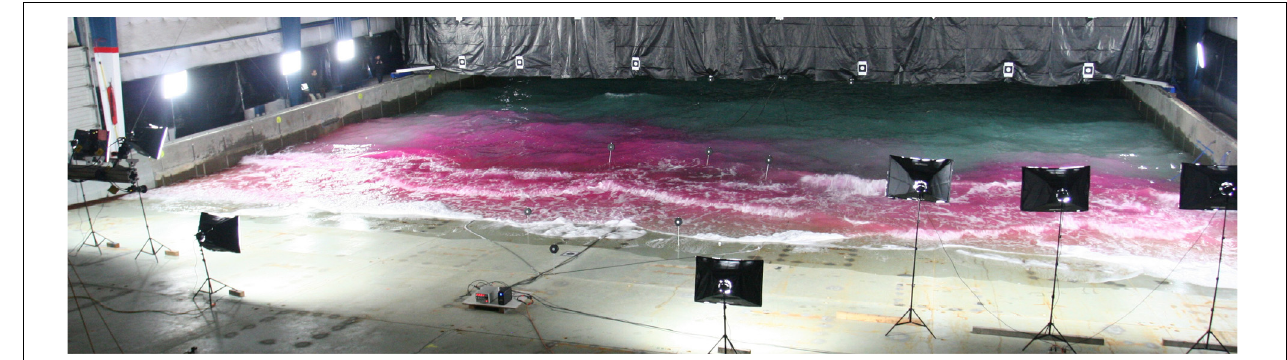
FIGURE 11 | Surf zone rip currents in DWB using dye tracers and optical